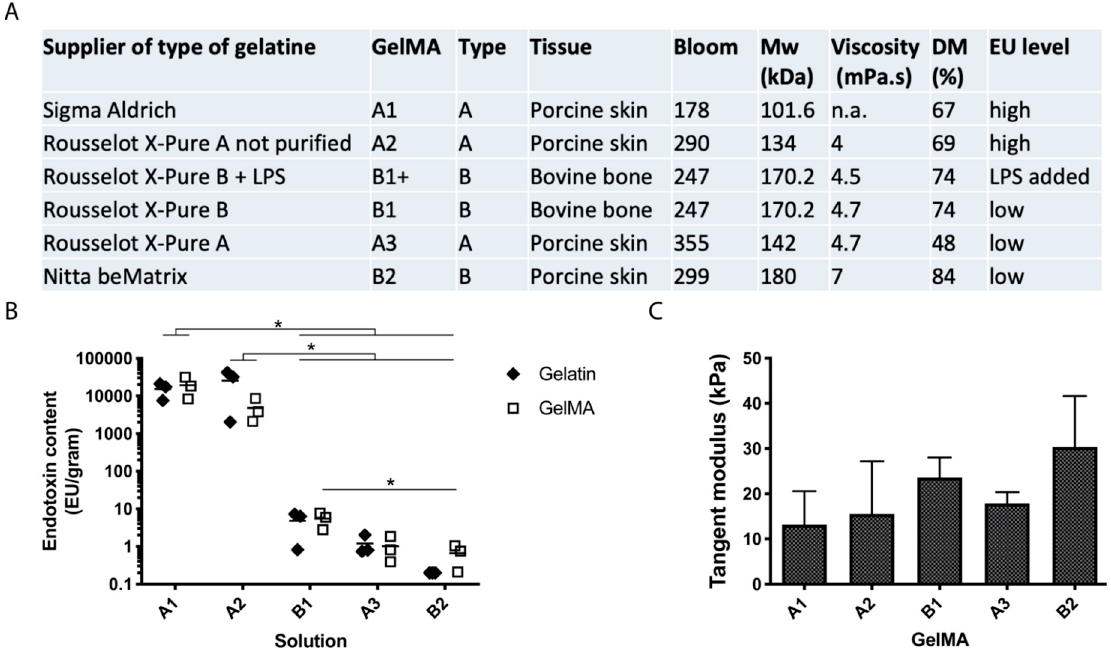
Figure 1. Gelatine and GelMA characteristics . ( A ) Data of gelatines and their GelMA derivatives used in this study, including specifications supplied by the fabricating company (type, tissue, bloom strength, Mw, viscosity) and additional measurements performed in this study (DM, EU level). ( B ) Endotoxin content of different gelatine and GelMA solutions. GelMAs are shown in order from high to low endotoxin content. ( C ) Compressive tangent moduli of hydrogels after crosslinking. Values represent mean + SD of independent experiments ( n = 3) with GelMA discs (2 to 10 technical replicates). *: p <